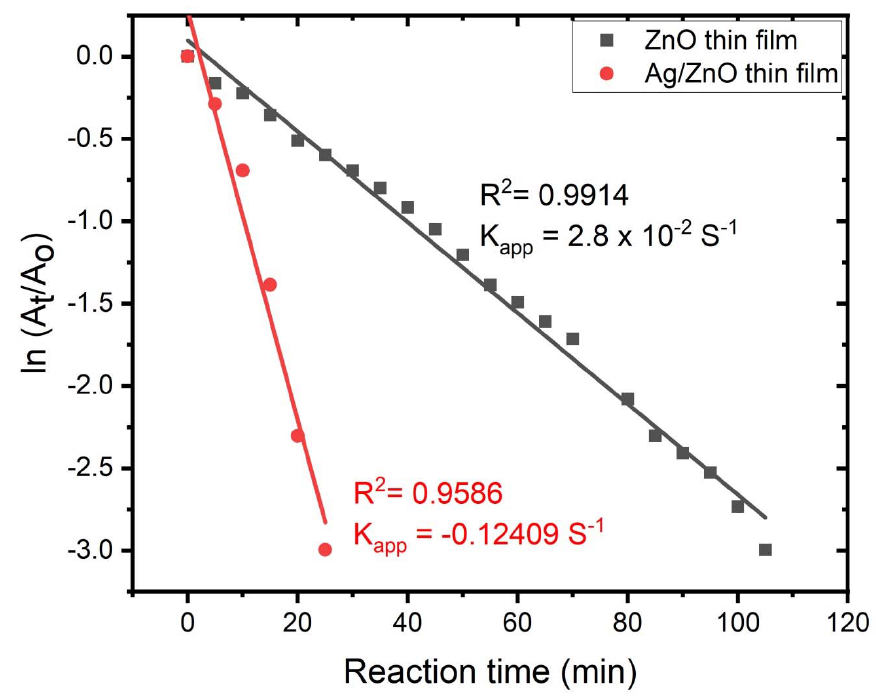
Figure 7. Investigation of ln(A t /A o ) with respect to reaction time (t) for the thin films (ZnO and Ag/ZnO) against 4-NP .